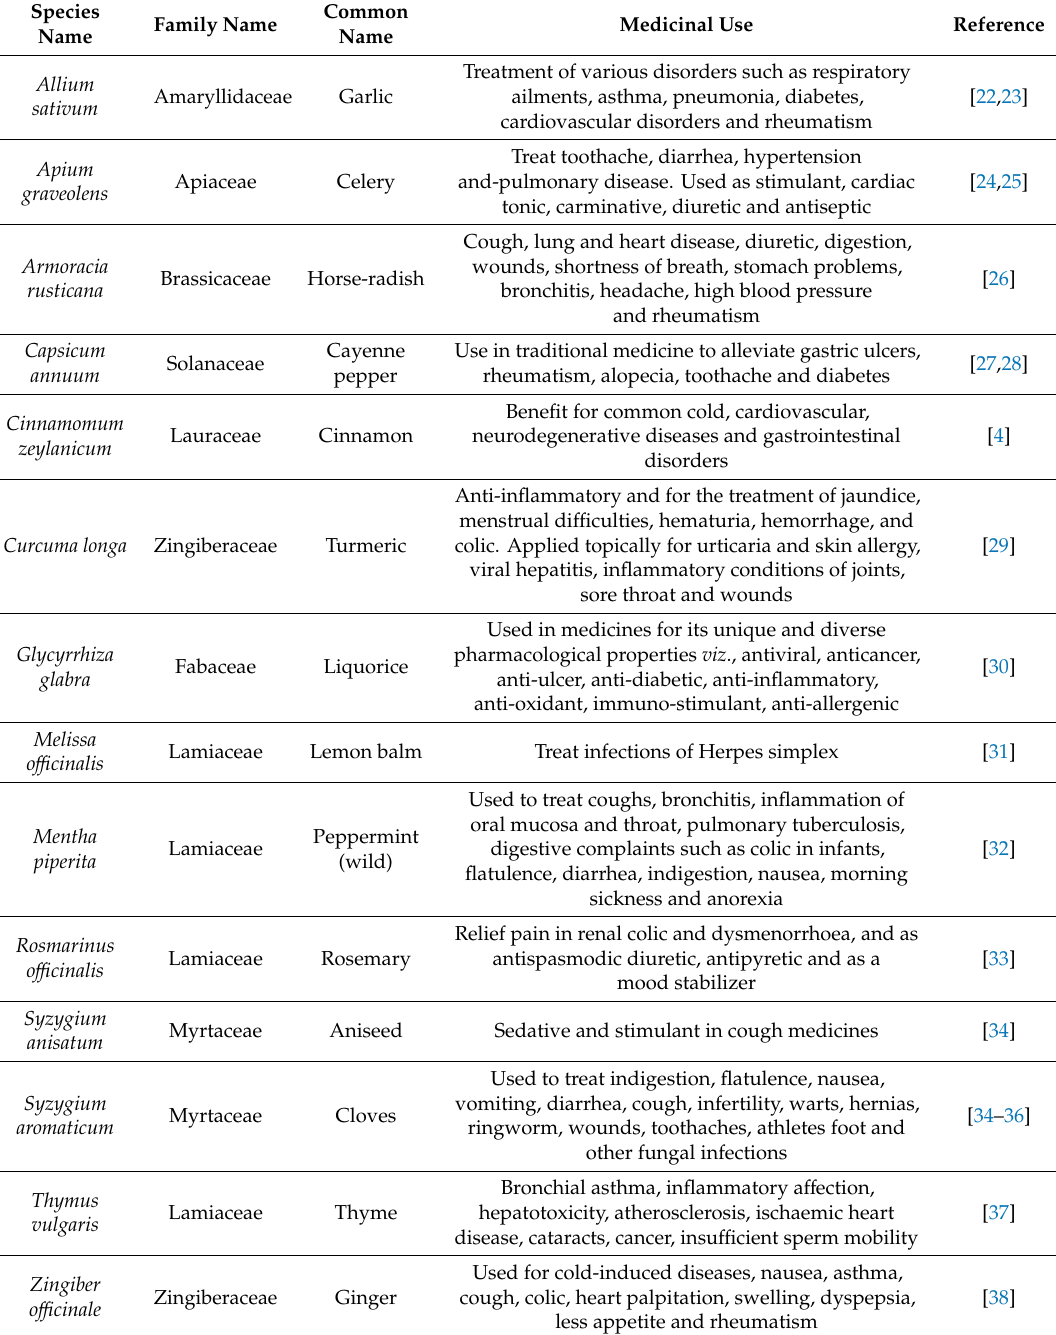
Table 1. Herbs and spices selected for screening for anti-quorum sensing (AQS)